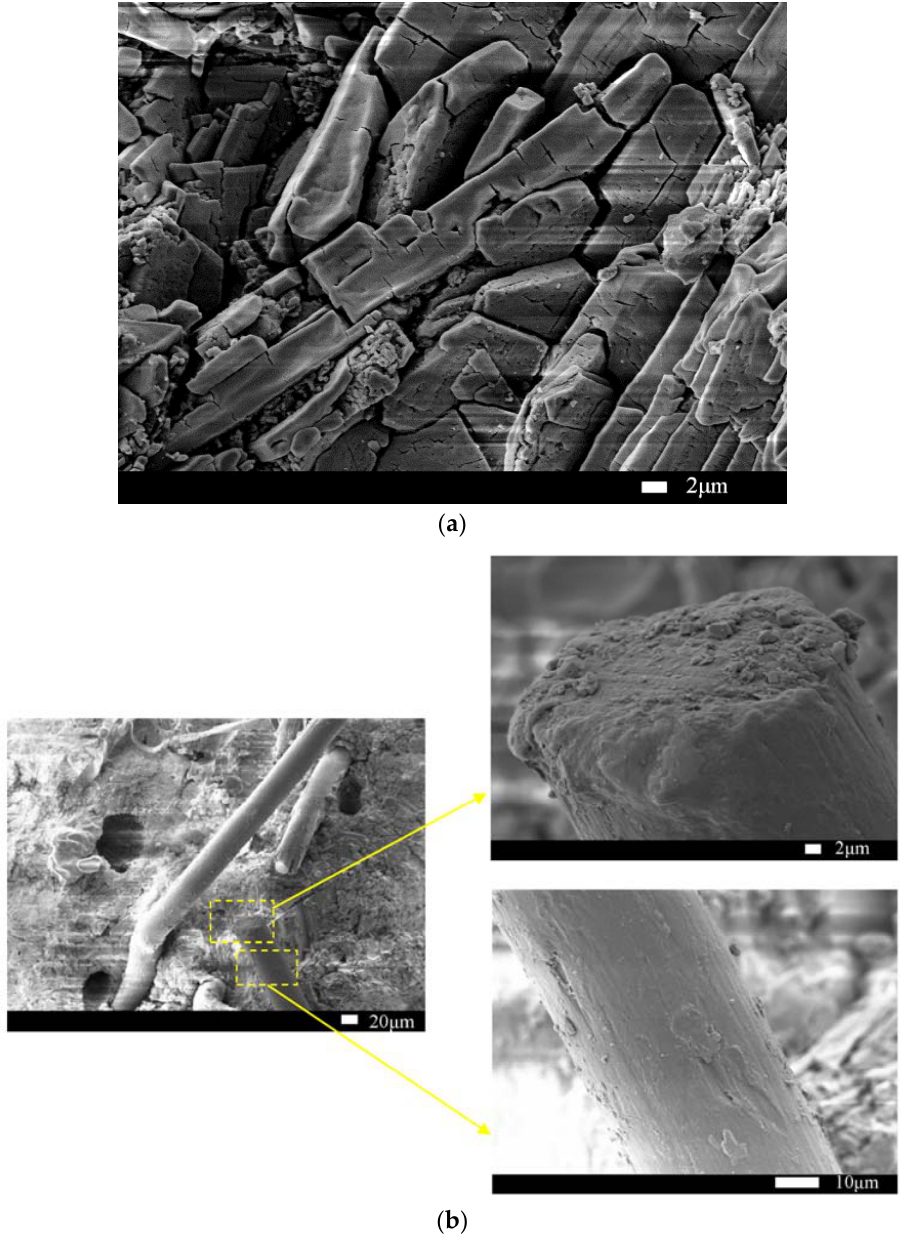
Figure 12. ( a ) The matrix and ( b ) its bonding with fibers for non-immersed HDMC.